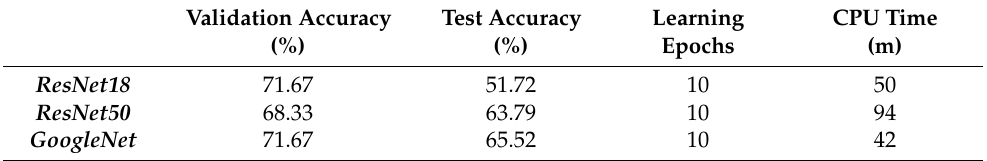
Table 5. Results of CNN classification